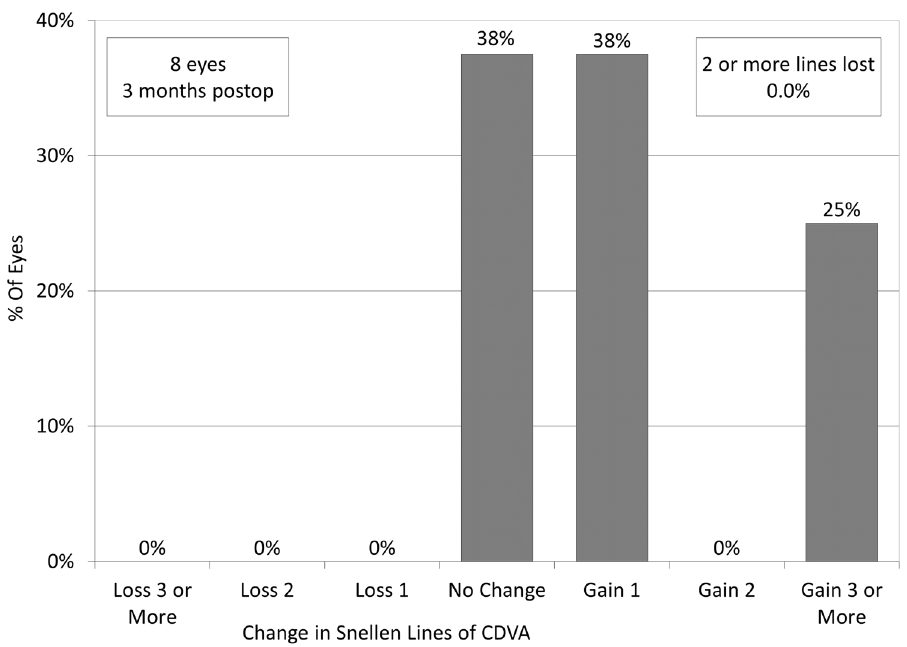
Figure 3. Changes in corrected distance visual acuity (CDVA) after implantable collamer lens (ICL)